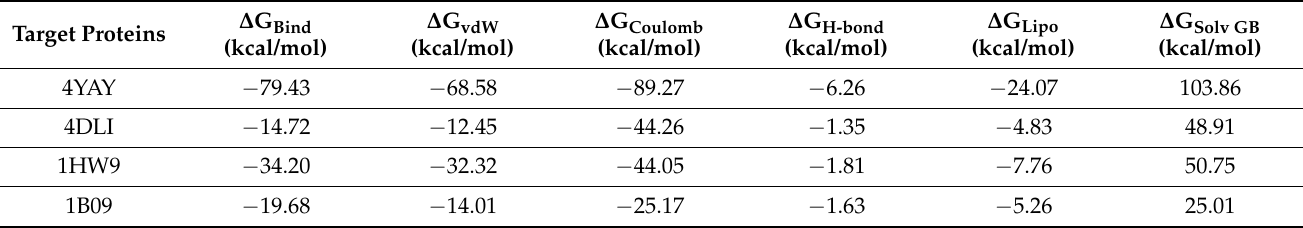
Table 2. MM/GBSA profiles of casuarinin while interacting with four targeted proteins.